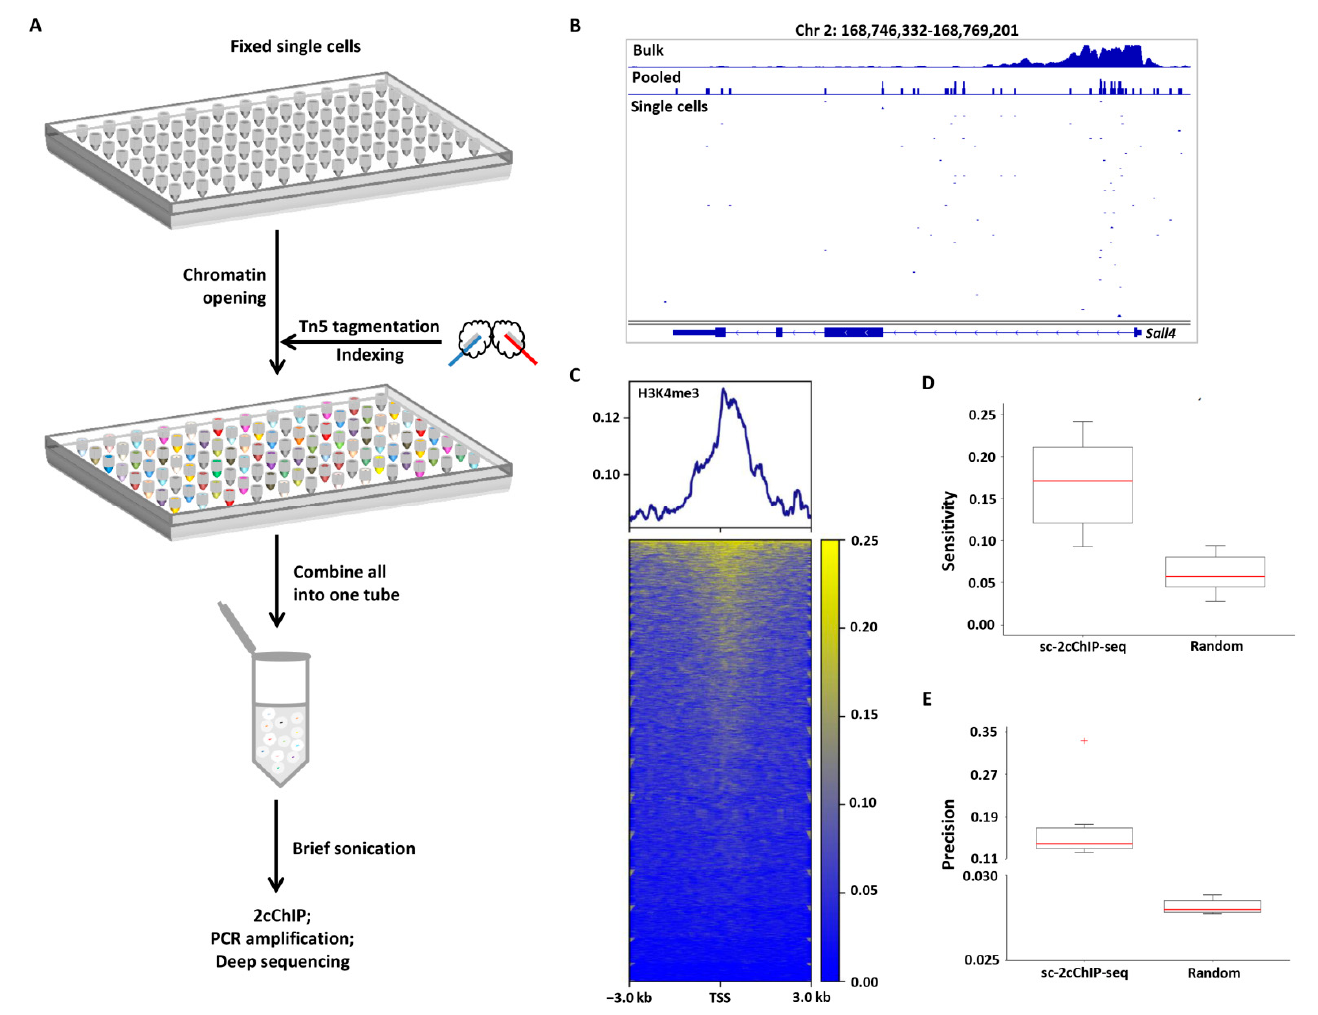
Figure 4. 2cChIP-seq profiles of H3K4me3 signals in single cells. ( A ) Workflow of single-cell 2cChIP- seq. ( B ) Integrative Genomics Viewer (IGV) track view showing the H3K4me3 profiles from ENCODE bulk-cell ChIP-seq data (GSM1003756), pooled single-cell 2cChIP-seq data (from two independent experiments), and 12 individual cells. ( C ) Heatmap showing H3K4me3 signals at the TSS ± 3 kb regions of genes for all single cells. ( D , E ) Boxplots showing the scores of sensitivity ( D ) and precision ( E ) for the top 5% of individual single cells, and simulated random genomic